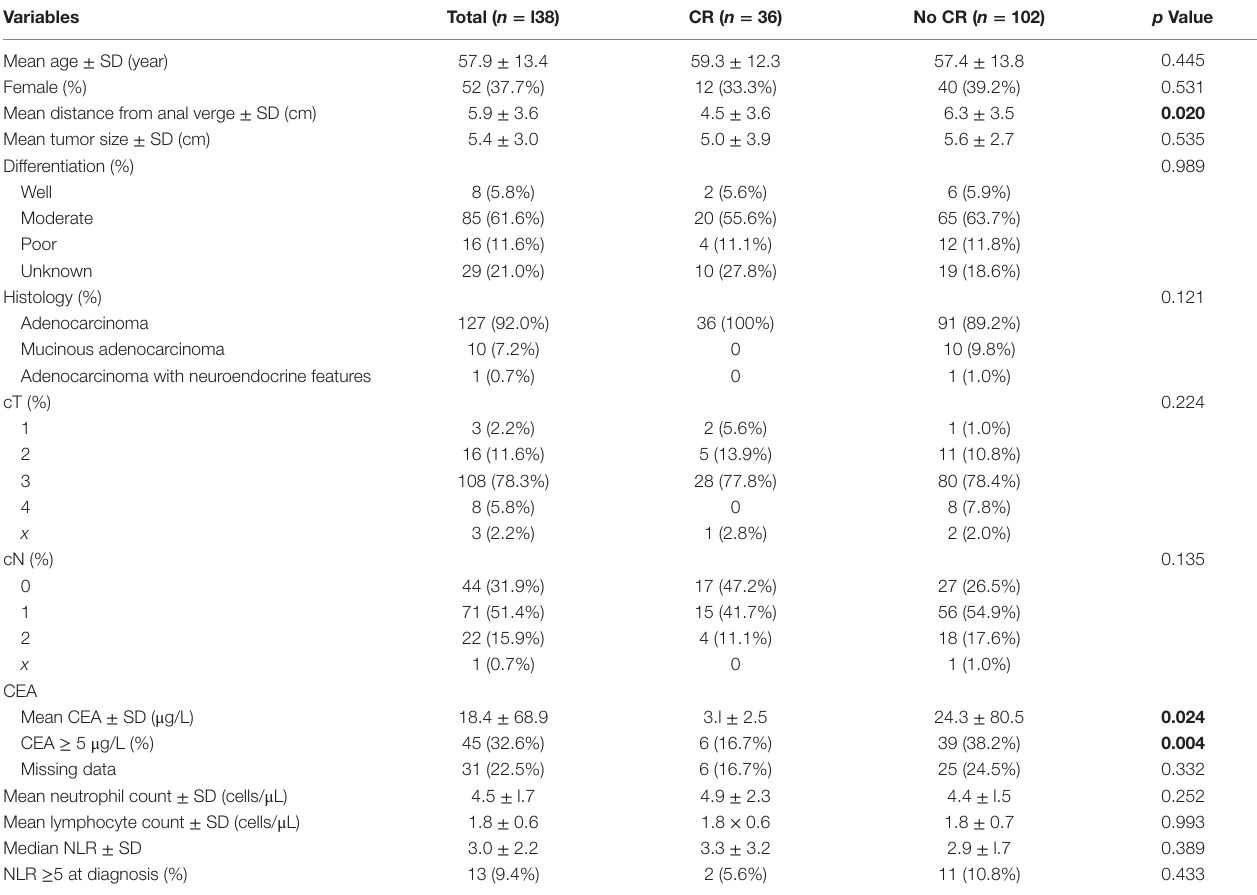
TaBle 1 | Baseline patient demographics and clinical characteristics.